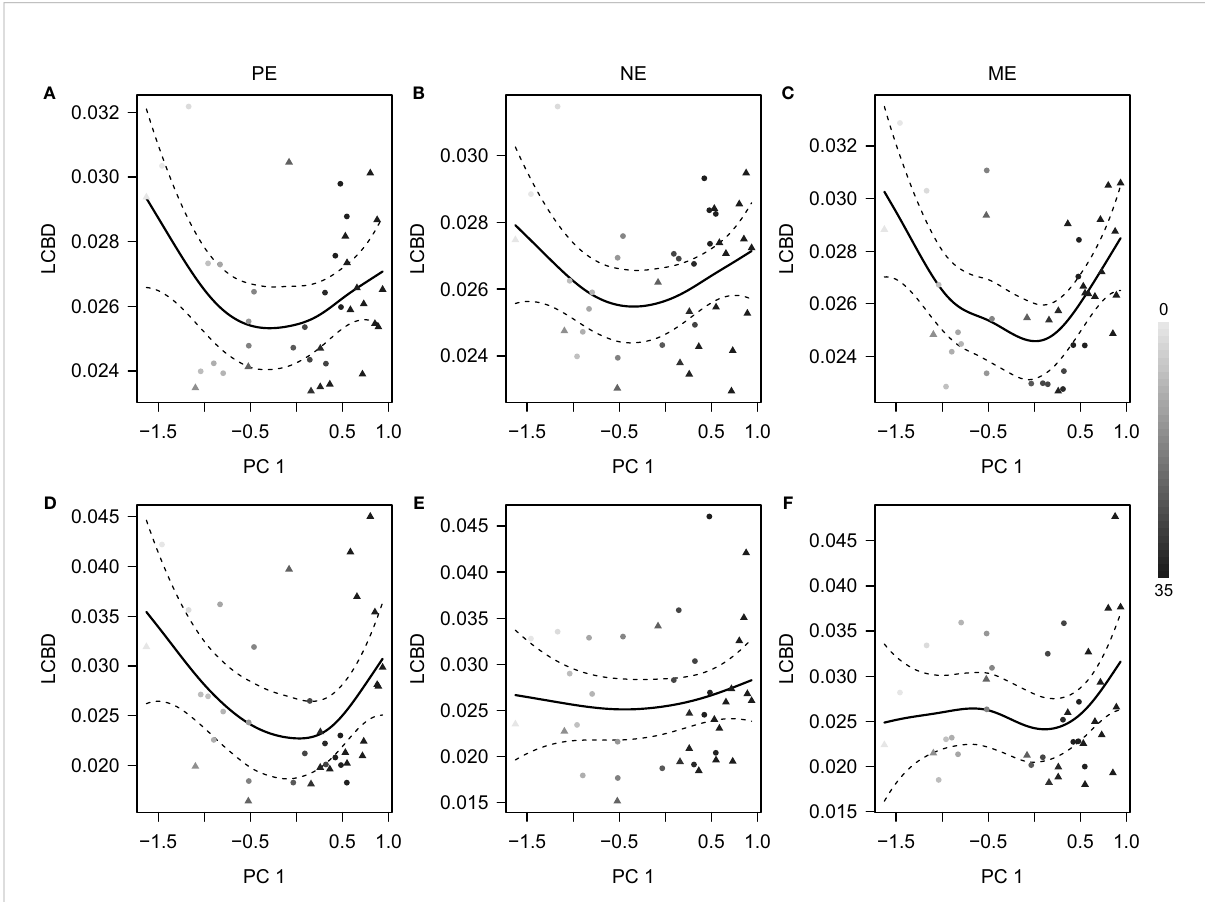
FIGURE 5 Relationship between the local contribution to beta diversity (LCBD) estimates and the fi rst axis of the principal component analysis of environmental factors (PC 1). Panels (A – C) and (D – F) are results based on the unweighted and weighted UniFrac distances, respectively, for the (A, D) PE, (B, E) NE, and (C, F) ME categories. The fi tted smoothers (solid lines with 95% con fi dence intervals) were predicted using generalized additive models. The shades of symbols ( fi lled circles, surface samples; fi lled triangles, bottom samples) indicate the local salinity at each